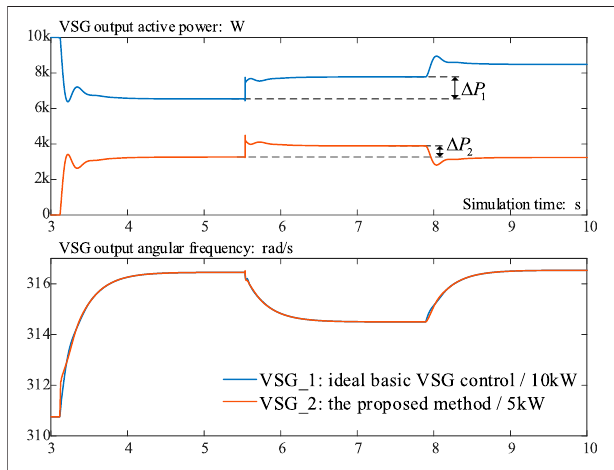
FIGURE 13 | Simulation results III: the proposed method and the ideal basic